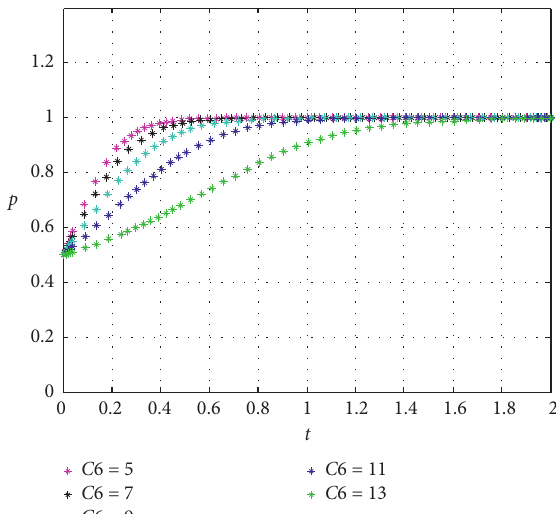
Figure 14: Evolutionary trajectory of owners’ behavior under . different C 6